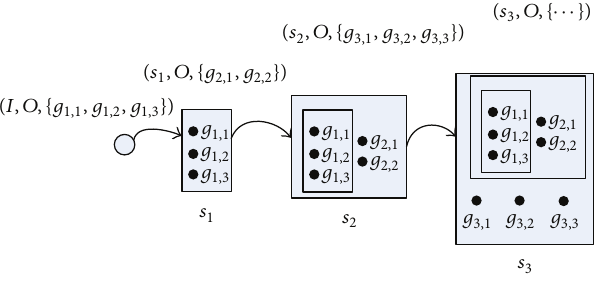
Figure 4: The incremental planning